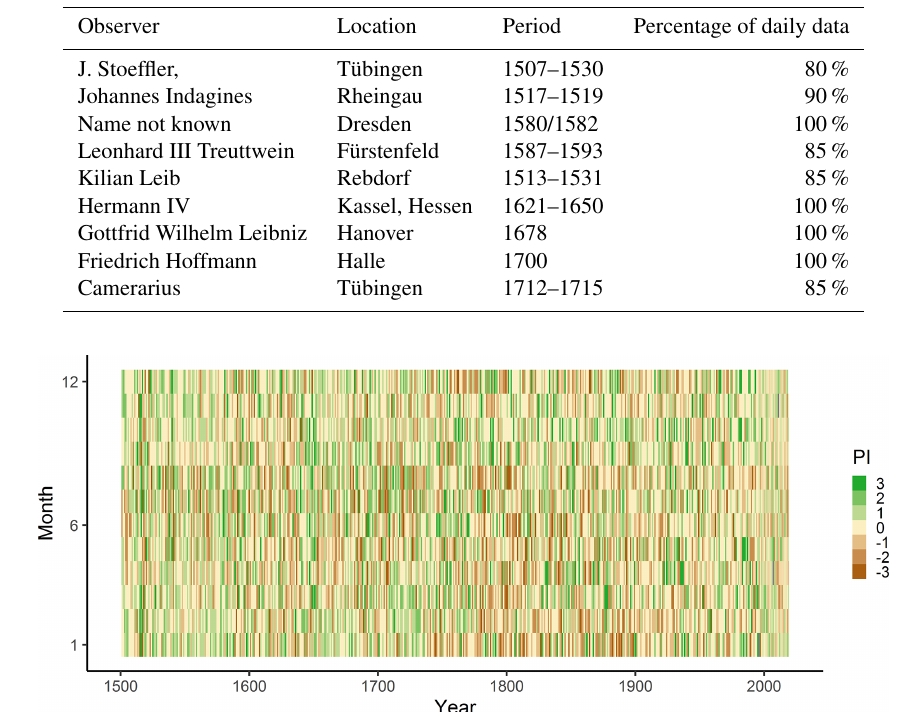
Table 2. Selected observers, location and periods with daily weather entries 1500–1800.